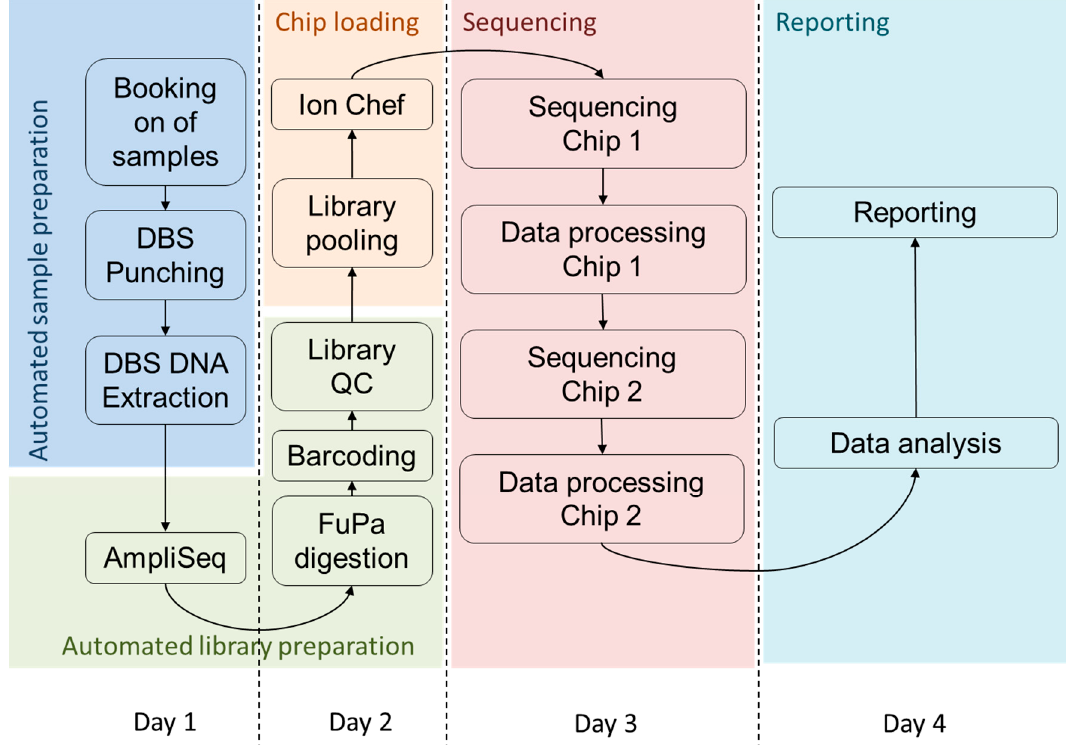
Figure 3. Timeline for automated fast turnaround time NGS from DBS. Booking on of samples and DNA extraction were carried out on Day 1. Automated AmpliSeq library preparation was initiated on Day 1 and PCR was run overnight. FuPa digestion (manual pooling and FuPa enzyme addition), automated barcoding, automated library QC, and automated library pooling were carried out on Day